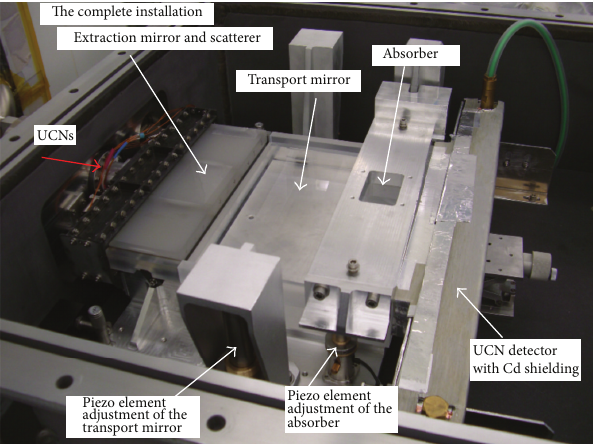
Figure 14: Number of UCNs detected for 30 min versus the free fall height. During the measurement, the temperature of He-II was 1.35 K. Since the UCN spectrum is defined by the storage and transmission properties of the whole system, and the temperature of He-II affects only the total count rates, the exact value of the temperatureisofnoimportance.Thismeasurementwasfittedwitha Monte-Carlo simulation, assuming an initial triangular or Gaussian spectrum.